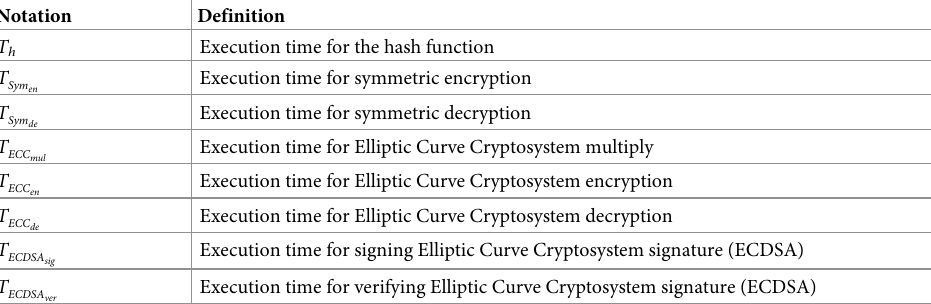
Table 3. Notation for the execution time of each